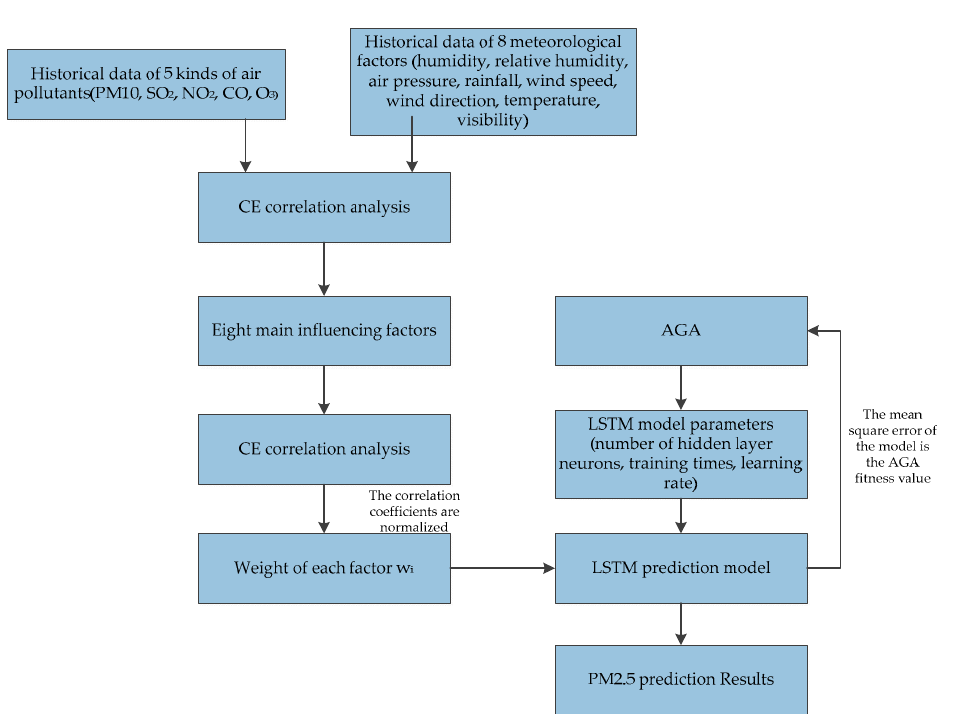
Figure 1. Basic framework of the AGA–LSTM prediction model. Basic process of the AGA–LSTM prediction